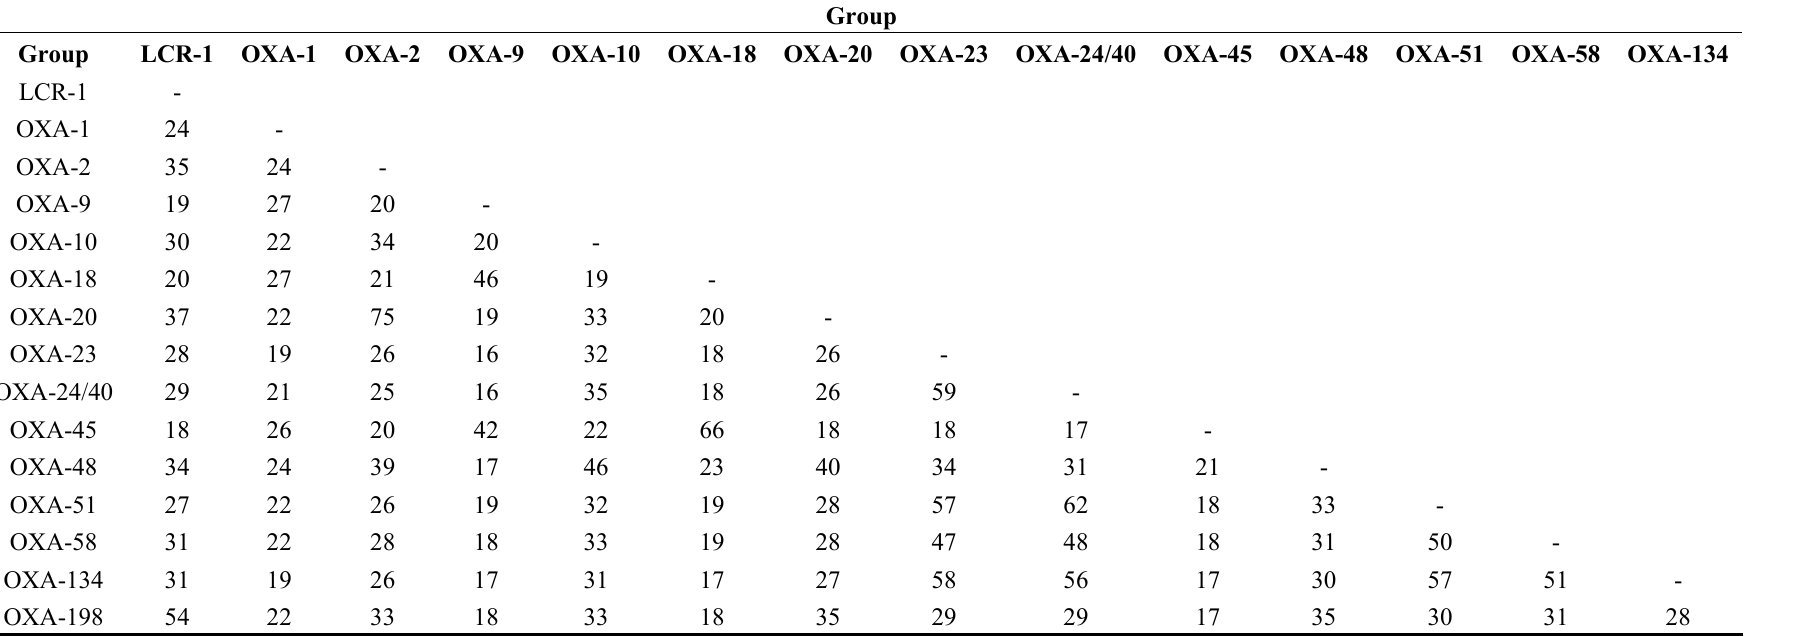
Table 1. Amino acid identities between the different groups of Class D